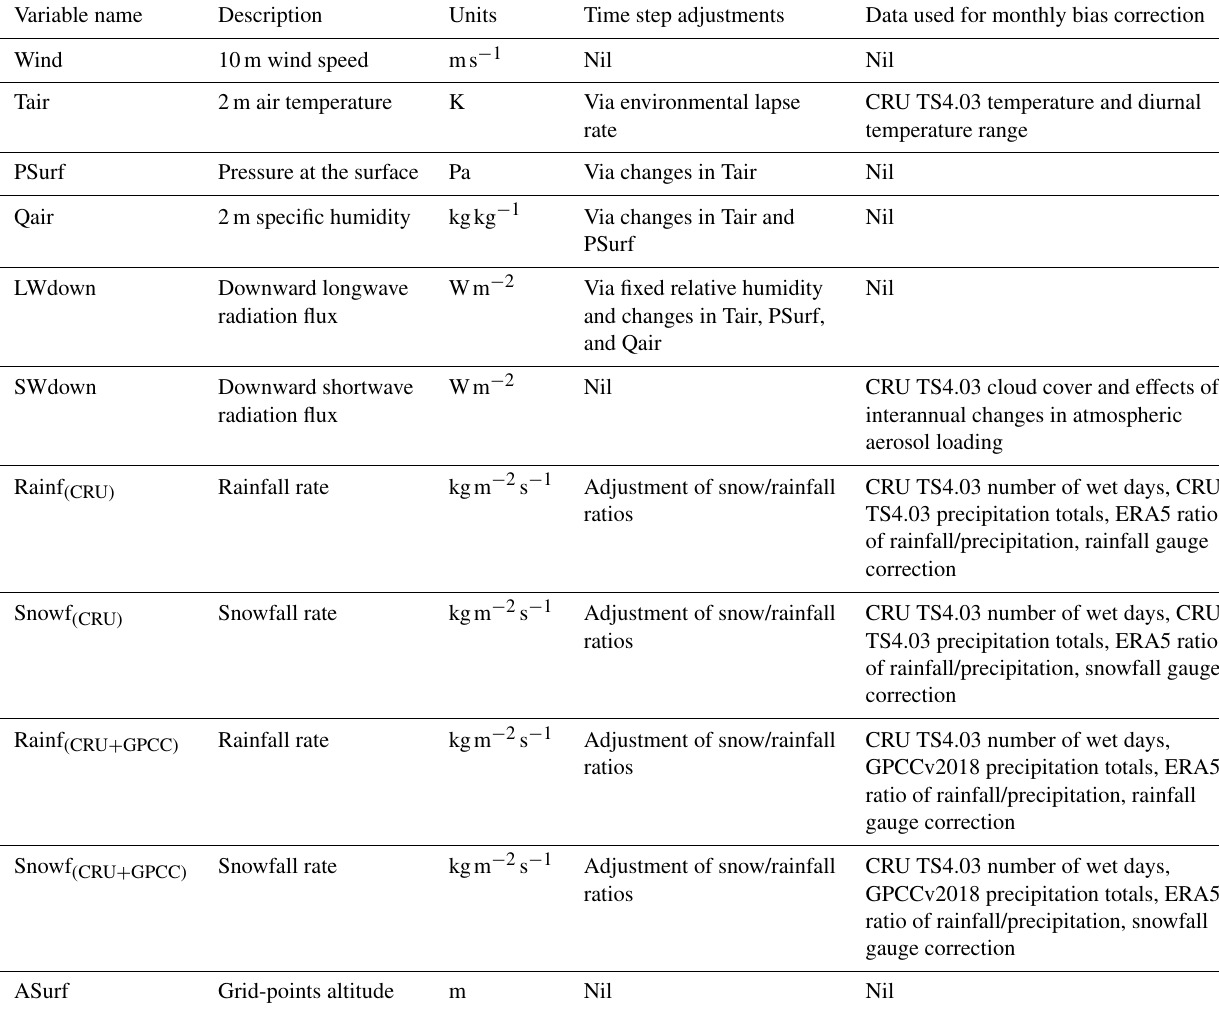
Variable names and units are based on the ALMA (Assistance for Land--surface Modelling Activities) conventions (https://www.lmd.jussieu.fr/~polcher/ALMA/, last access: 26 August 2020). Wind, Tair, PSurf, and Qair variables have instantaneous values, while LWdown, SWdown, Rainf, and Snowf are averaged over the next hour at each date